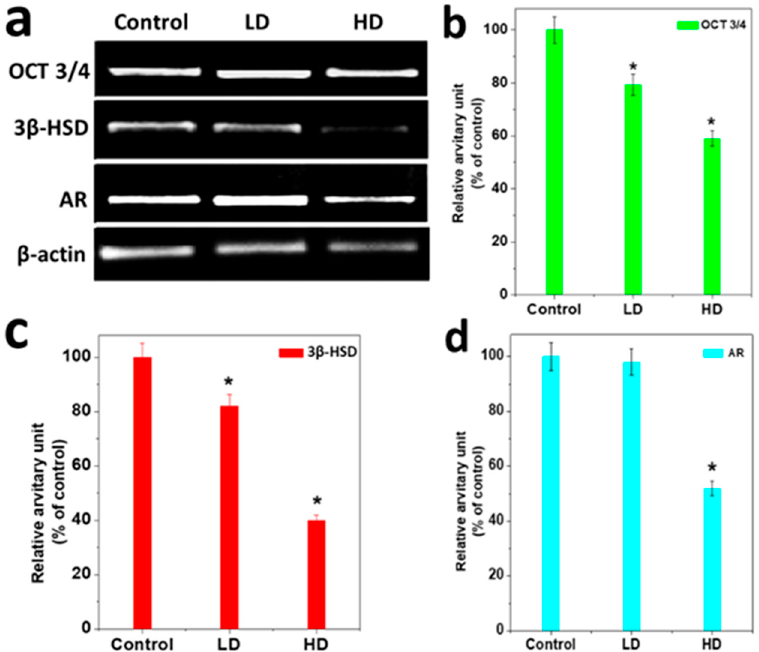
Figure 5 . Transcriptional profilesof TCS responses for some testicular genes. ( a ) RT-PCR results of testicular mRNA for OCT 3/4, 3 β HSD, and AR genes. All histograms show results as mean ± S.E.M. of the relative arbitrary units of the experimental bands. The control result is denoted as 100%. ( b ), OCT 3/4 genes ( c ), 3 β HSD gene and ( d ) androgen receptor (AR). The relative intensities of the signals were quantified by a densitometer and normalized against the internal control ( β -actin). *significant results compared to the control at p < 0.05.